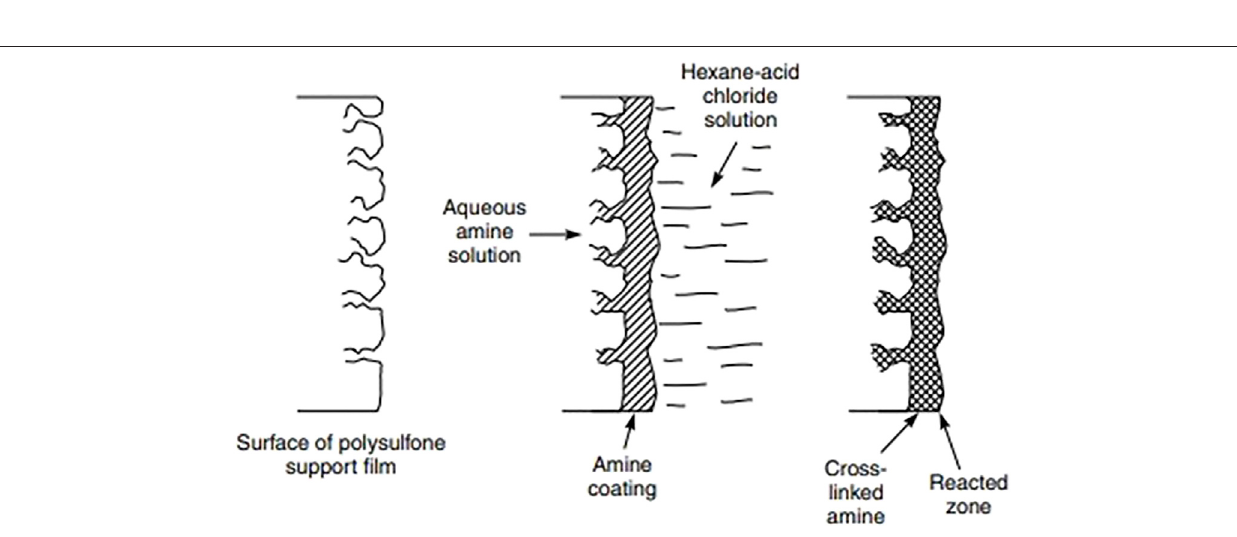
Frontiers in Chemistry |